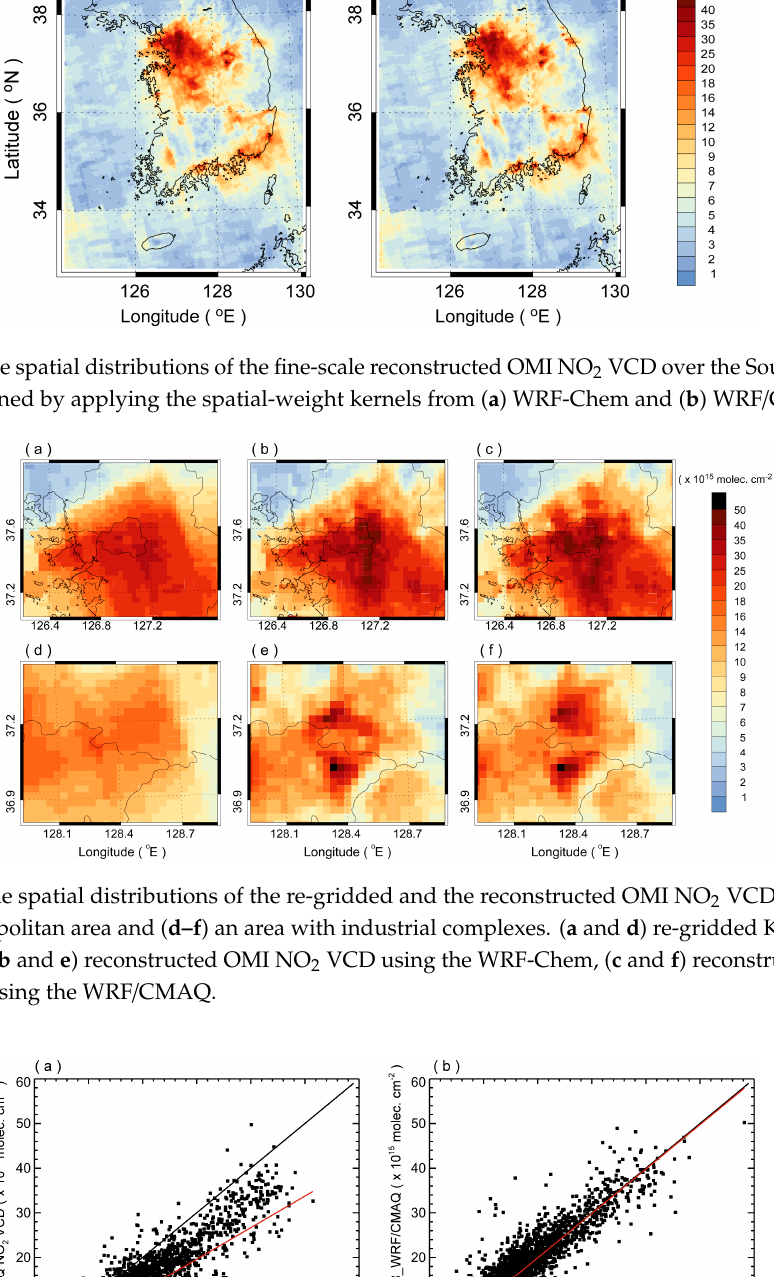
Figure 9. (a) The spatial distribution of the reconstructed OMI NO 2 VCD over the South Korean region and (b) the frequency distribution of the grid-scale normalized absolute difference defined as (cid:3627)(cid:3016)(cid:3014)(cid:3010)_(cid:3005)(cid:3020) (cid:3272)(cid:3267)(cid:3255)(cid:3127)(cid:3252)(cid:3283)(cid:3280)(cid:3288) (cid:2879)(cid:3016)(cid:3014)(cid:3010)_(cid:3005)(cid:3020) (cid:3272)(cid:3267)(cid:3255)/(cid:3252)(cid:3262)(cid:3250)(cid:3266) (cid:3627) (cid:2868).(cid:2873)(cid:3435)(cid:3016)(cid:3014)(cid:3010)_(cid:3005)(cid:3020) (cid:3272)(cid:3267)(cid:3255)(cid:3127)(cid:3252)(cid:3283)(cid:3280)(cid:3288) (cid:2878)(cid:3016)(cid:3014)(cid:3010)_(cid:3005)(cid:3020) (cid:3272)(cid:3267)(cid:3255)/(cid:3252)(cid:3262)(cid:3250)(cid:3266) (cid:3439) . 3.3. Effective Spatial Resolution and Detection Capability of Strong NOx Emissions